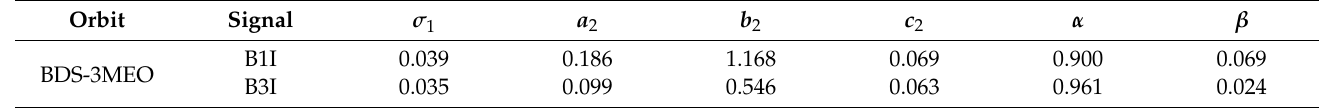
Table 3. Parameters of constructed models with two inflation factors. Table 4. Parameters of constructed models with single inflation